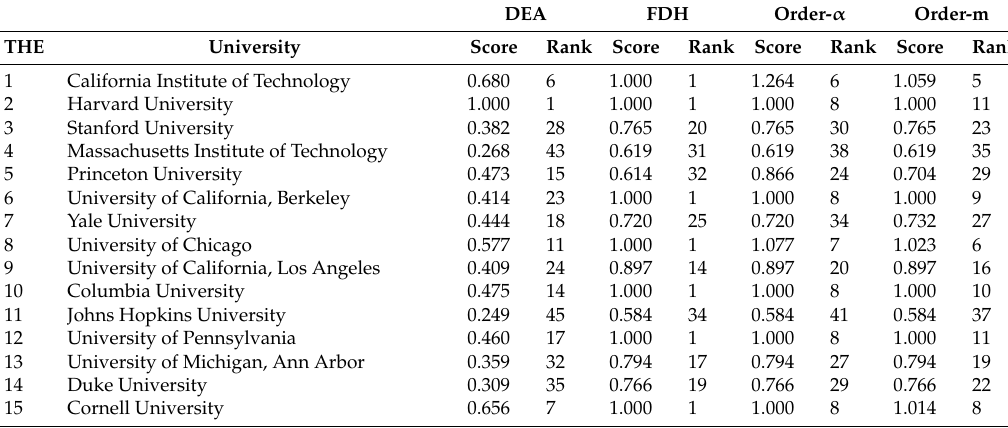
Table 2. Efficiency scores and the corresponding rankings based on different approaches for measuring efficiency in 2013 (sorted by THE Ranking).